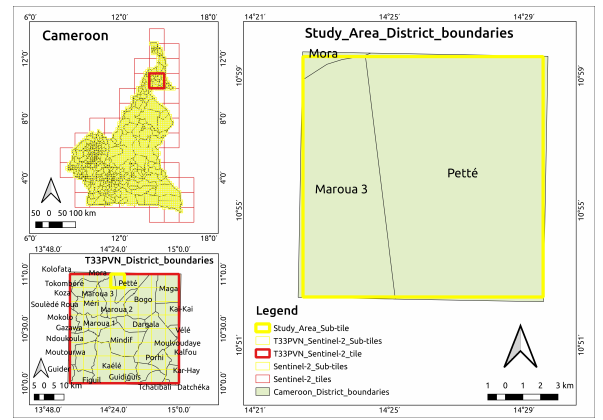
Figure 1. Location of the study area in